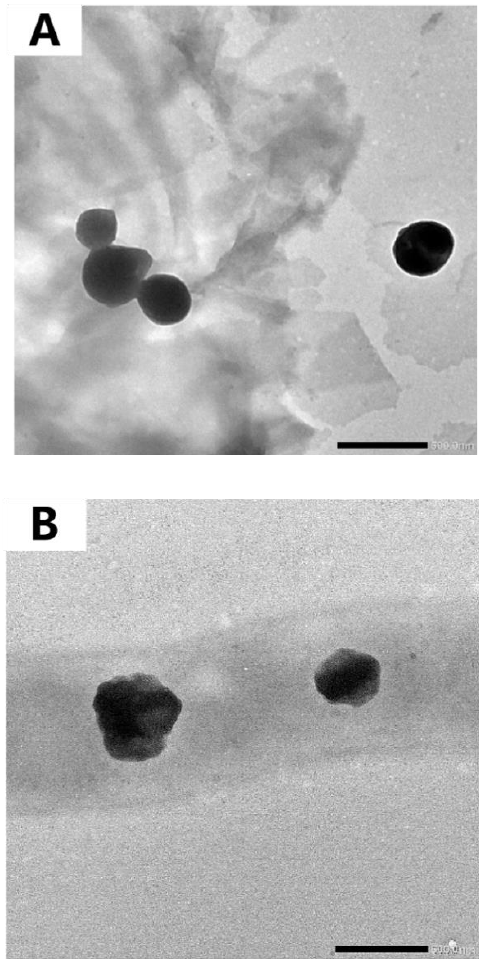
Figure 7. TEM images of BPNs (1:1) ( A ) and BPENs (1.0) ( B ).